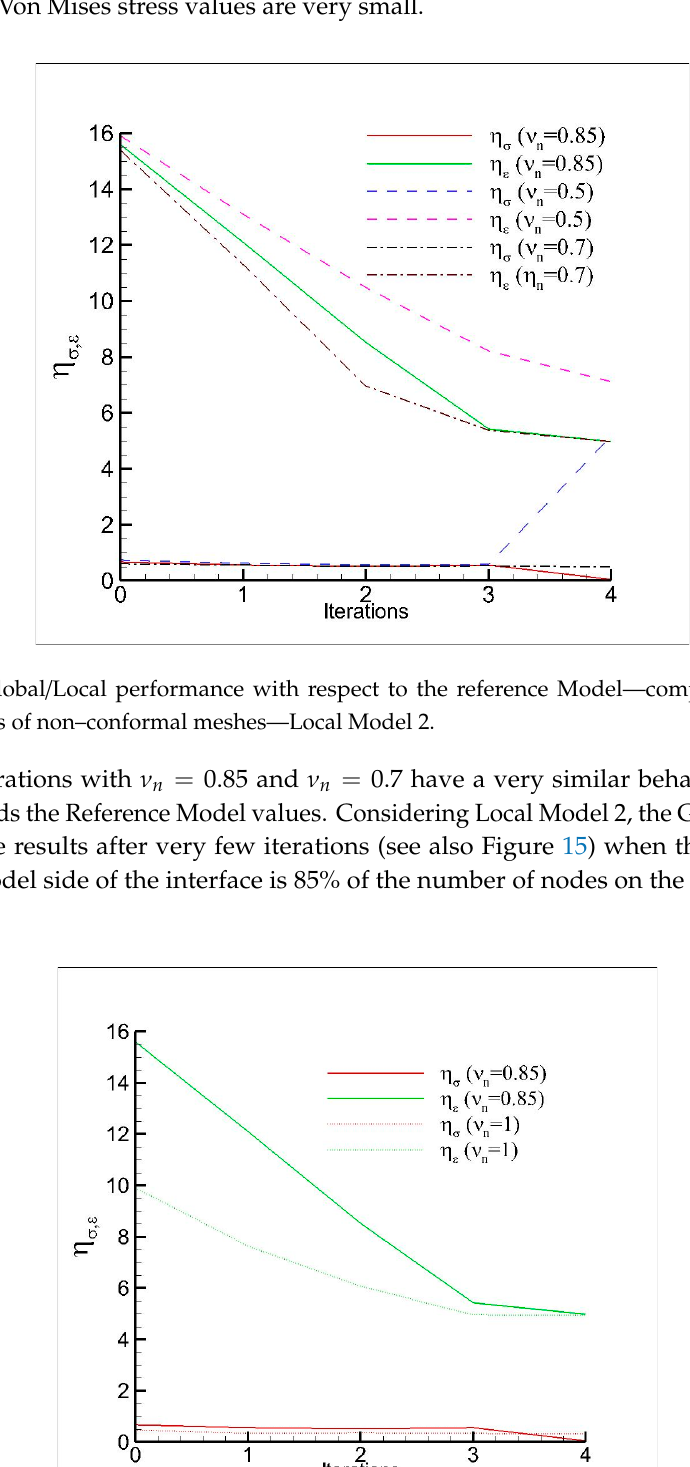
(cid:3041) = 0.5 and (cid:2021) (cid:3041) = 0.7 ensure good results even if (cid:2015) (cid:3084) slightly increases after the first iteration (see Figures 16 and 17).